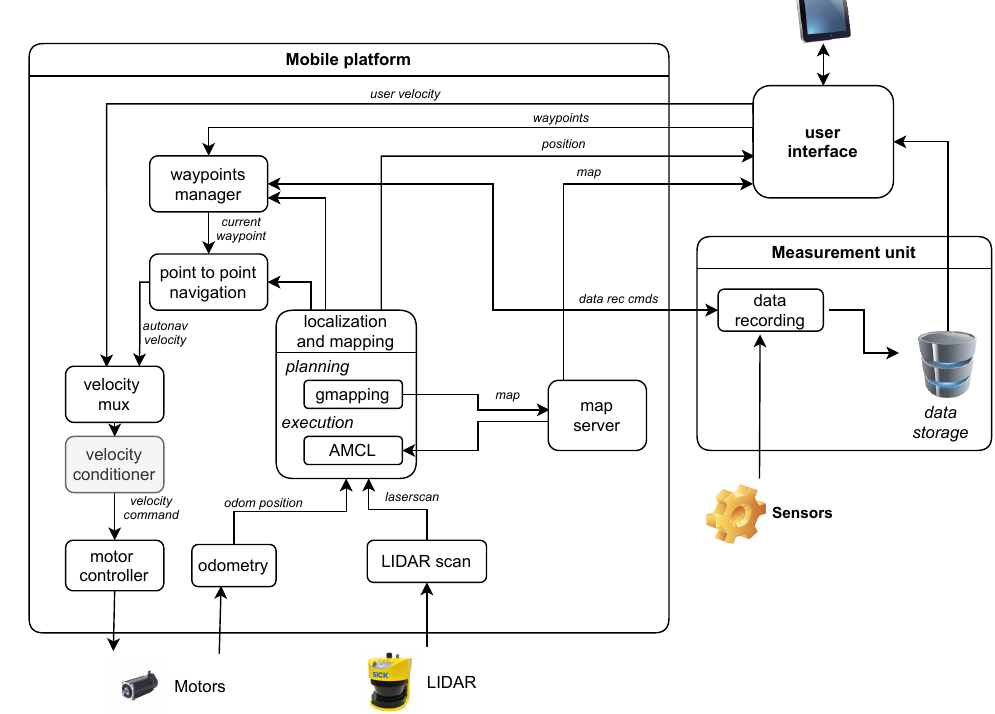
Figure 10. Software components of the system and data